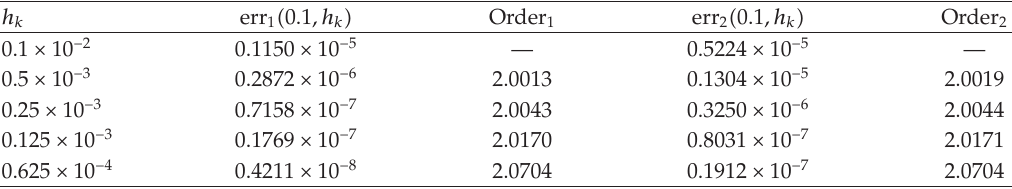
Table 3: The error and the convergence